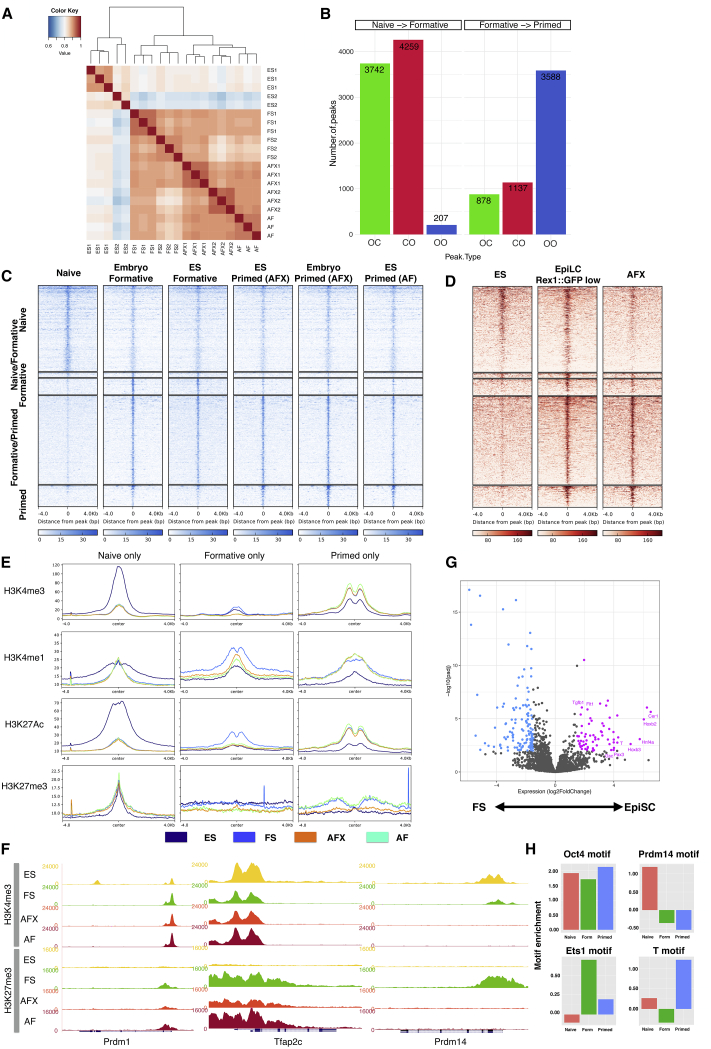
Chromatin Landscape Analysis(A) Hierarchical clustering of all ATAC-seq peaks.(B) Peak changes between states. OC, open to closed; CO, closed to open; OO, open to open.(C) Heatmaps of differential ATAC-seq peaks.(D) Heatmaps of ATAC-seq peaks from (C) in EpiLCs and EpiSCs derived from RGd2 ESCs.(E) Histone modification patterns at ATAC-seq peaks.(F) Genome browser screenshots of H3K4me3 and H3K27me3 distribution at Prdm1, Tfap2c, and Prdm14 loci.(G) Volcano plot showing expression fold changes for genes associated with ATAC-seq peaks shared between FS cells and EpiSCs. Purple, upregulated in EpiSCs; blue, upregulated in FS cells.(H) Transcription factor binding motif enrichments at ATAC-seq peaks.